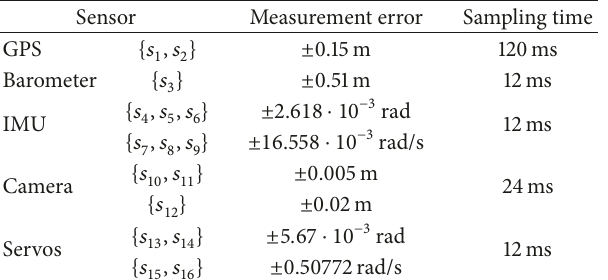
Table 2: Sensors parameters for the considered